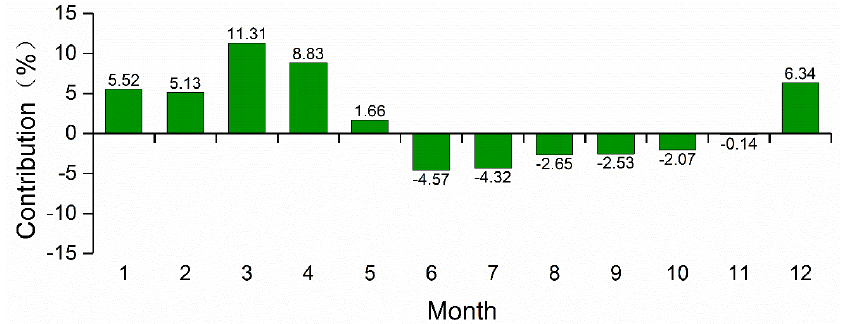
Figure 14. Contribution of Changes in Upstream Flow (Lancang River) to the Monthly Runoff Measured at the Stung Treng Hydrological Station after 2008.